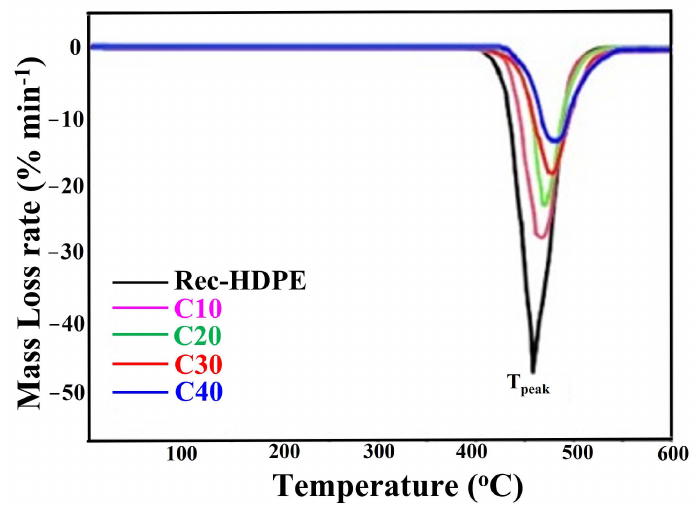
Figure 10. DTG curves of the recycled HDPE and